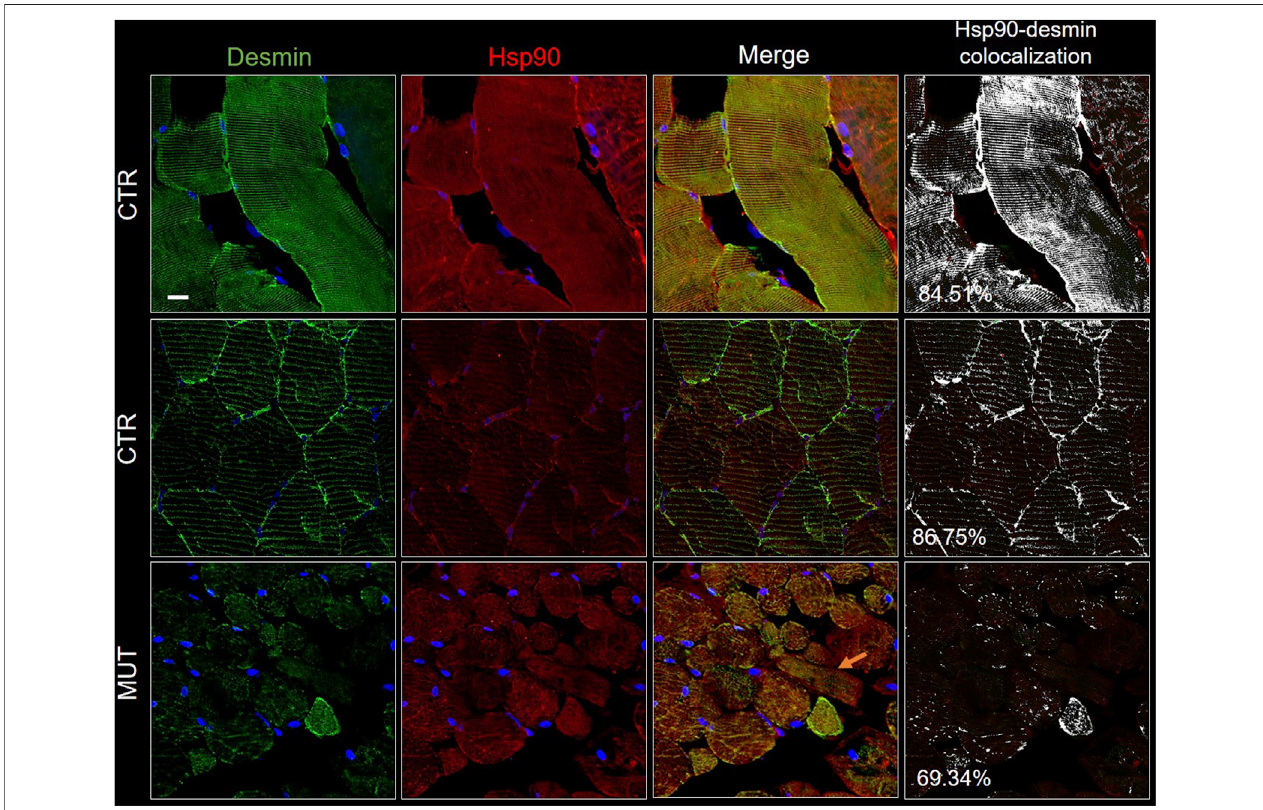
FIGURE9| Doubleimmuno fl uorescencewithFITC-conjugatedantibodyfordesmin(green)andwithTRITCconjugatedanti-Hsp90antibody(red)inCTRandMUT muscles.Hsp90positivitywaswellorganized inlongitudinaland transversalsections oftheCTRmuscle,but incontrast,itwasdisrupted and weaker intheMUT muscle (see forexample theMUT musclelongitudinal fi berindicatedbytheorangearrow on theMUT “ Merge ” panel).Hsp90and desmin colocalization washigh inCTRmuscle (longitudinalsection,84.51%;transversalsection,86.75%)bycomparisonwiththeMUTmuscle(forexample,itwas69.34%inMUTmuscletransversalsection,as shown in this fi gure). Nuclei were stained with probe Hoechst 33342 (blue). Bar = 25 µm.